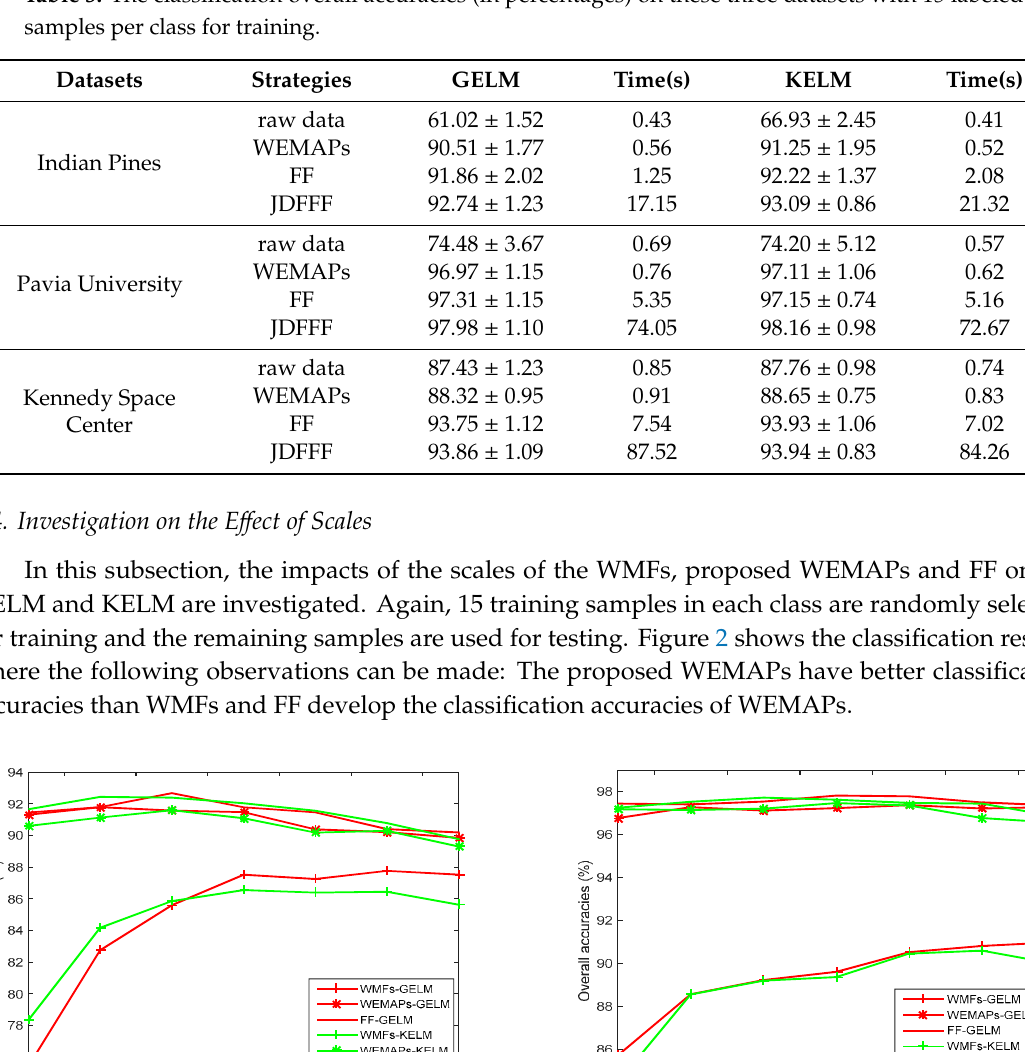
Table 3. The classification overall accuracies (in percentages) on these three datasets with 15 labeled samples per class for training.